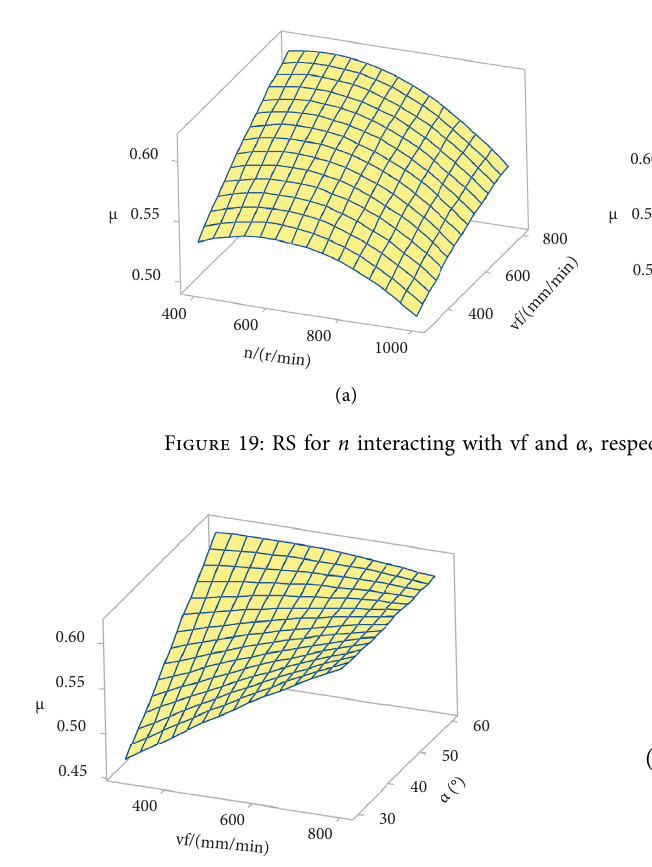
Figure 20: RS for vf interacting with α . (a) μ � f (vf, α